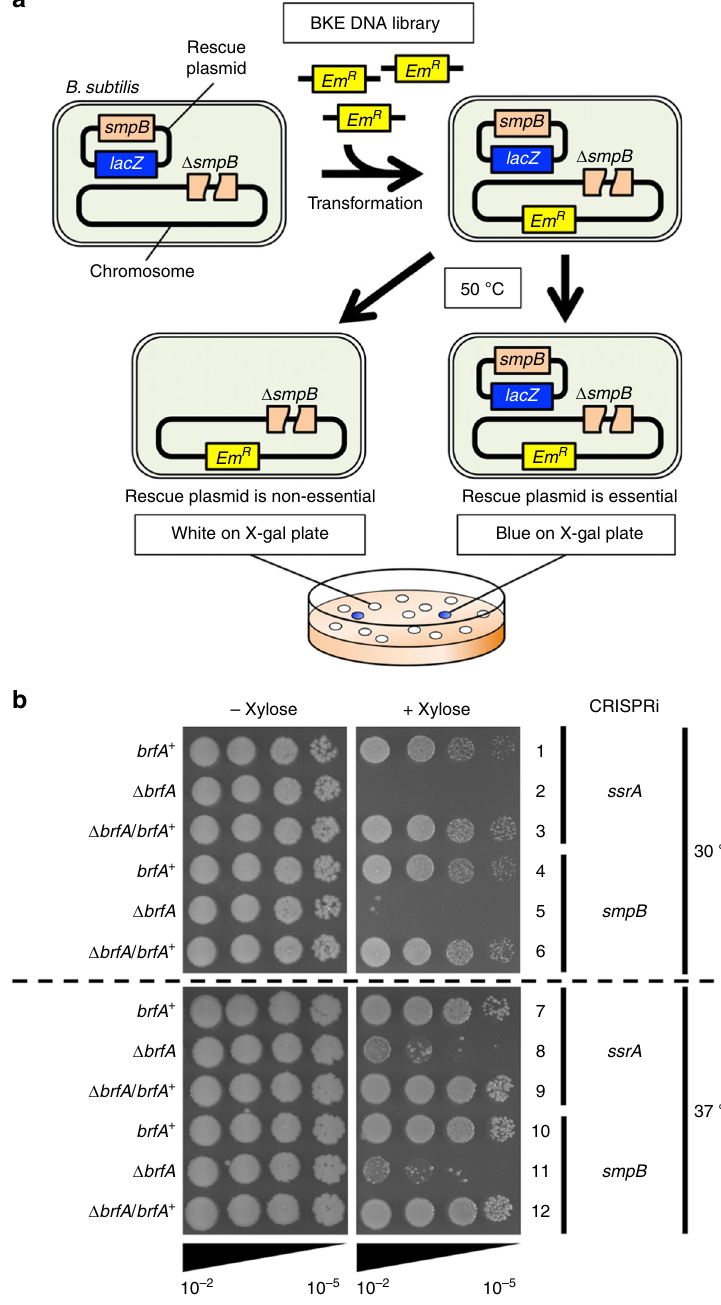
Fig. 1 Simultaneous loss of BrfA and trans- translation leads to synthetic growth defects. a A schematic representation of the synthetic lethal screening to identify genes whose absence causes synthetic lethal phenotype with the de fi ciency of trans -translation. b Xylose-inducible CRISPRi was targeted to ssrA (lines 1 – 3, 7 – 9) or smpB (lines 4 – 6, 10 – 12) in the B. subtilis strains indicated at the left by the genotypes of the brfA gene ( Δ brfA / brfA + signi fi es the presence of brfA + in an ectopic locus). Cultures prepared in the absence of xylose were serially diluted (from 10 − 2 to 10 − 5 ) and spotted onto LB agar plates with or without 1% xylose, as indicated at the top, for incubation at 30 °C (upper) or 37 °C (lower) for 17